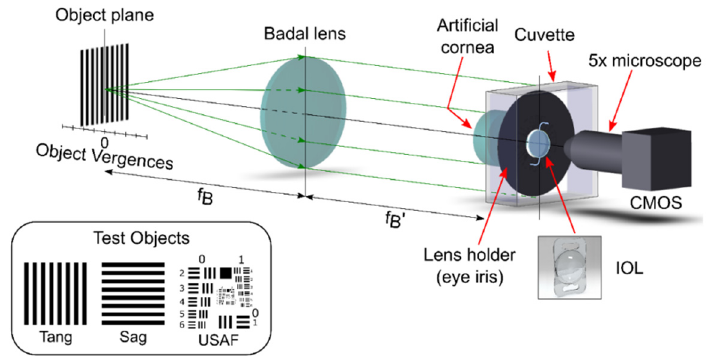
Figure 2. Optical bench. The test object can be illuminated by a monochromatic or polychromatic collimated beam (see the main text for details).